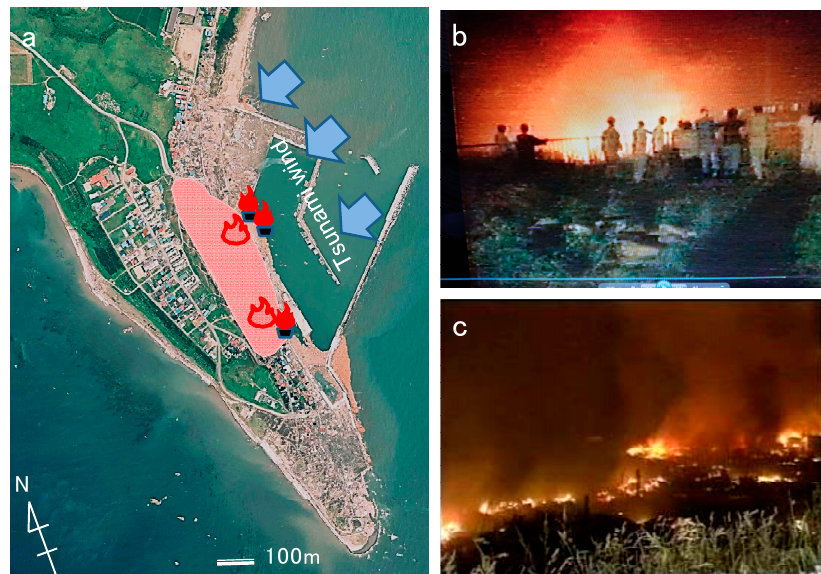
Figure 3. ( a ) Aerial photograph of the Aonae urban area (GSI) where sections 1–4 were destroyed. ( b , c ) Views of urban area fires spread by gusts accompanying the second tsunami wave after the burning fishing boats were blown ashore. The source: The “NHK Special” program entitled “ Oo-tsunami ga osotta, Okushiri-t ō karano Houkoku ” (in Japanese), broadcast on July 16,